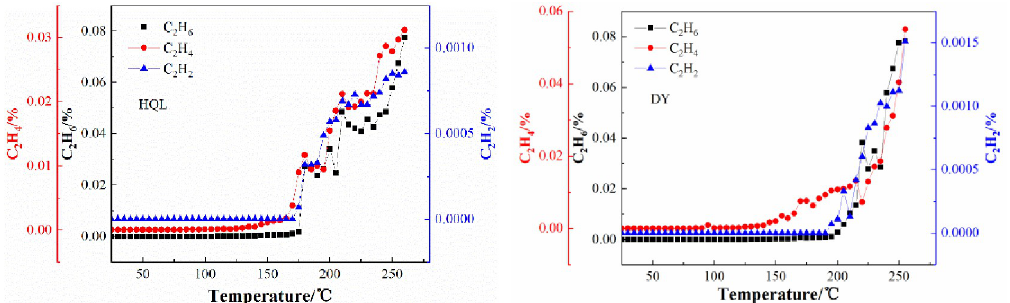
Fig 4. Variation in the concentration of representative gases with the oxidation temperature of the coal sample.